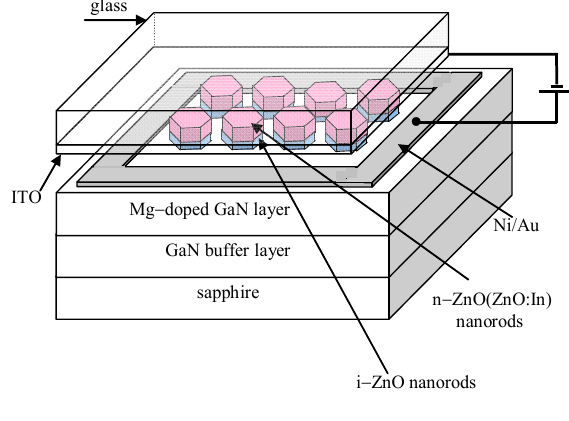
Figure 24. Schematic of p -GaN layer/ i -ZnO nanorod array/ n -ZnO:In nanorod array heterostructured LEDs.